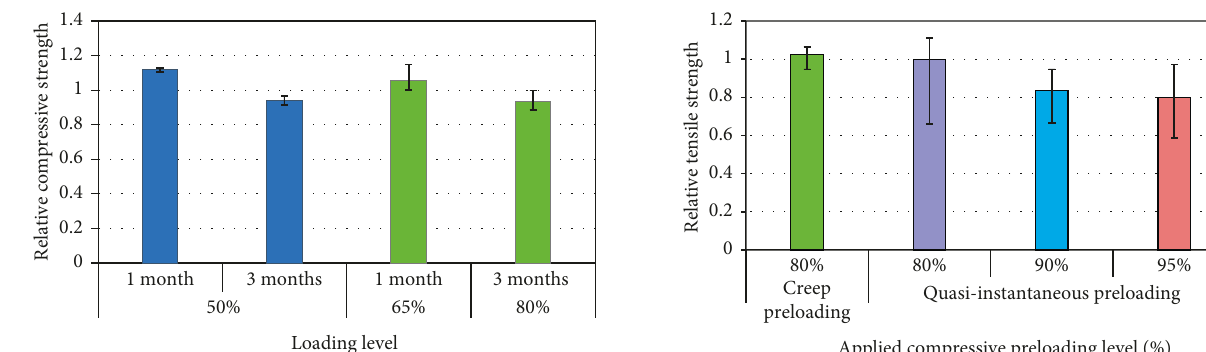
Figure 13: Compressive strength of creep-loaded specimens (relative to the average unloaded specimens) vs. the creep loading level for two loading ages (1 and 3months). The error bar repre- sents the maximum and minimum relative strength values (for 3 specimens). The variabilities of 3 accompanying control specimens ranged between +0.04 and − 0.06 for a specimen loading level of 65%; +0.04 and − 0.03 for a 50% loading level applied at an age of 1month; and ± 0.02 for 50% and 80% loading levels applied at an age of 3 months.